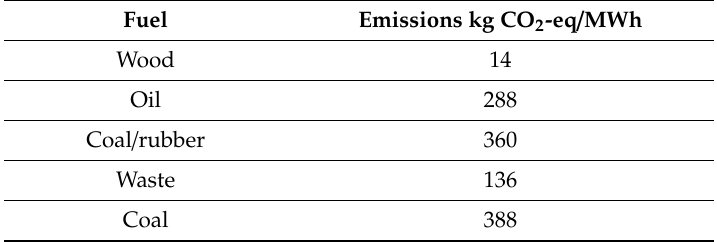
Table 7. Emissions of greenhouse gas (GHG) CO 2 -eq for each fuel, The Environmental Fact Book